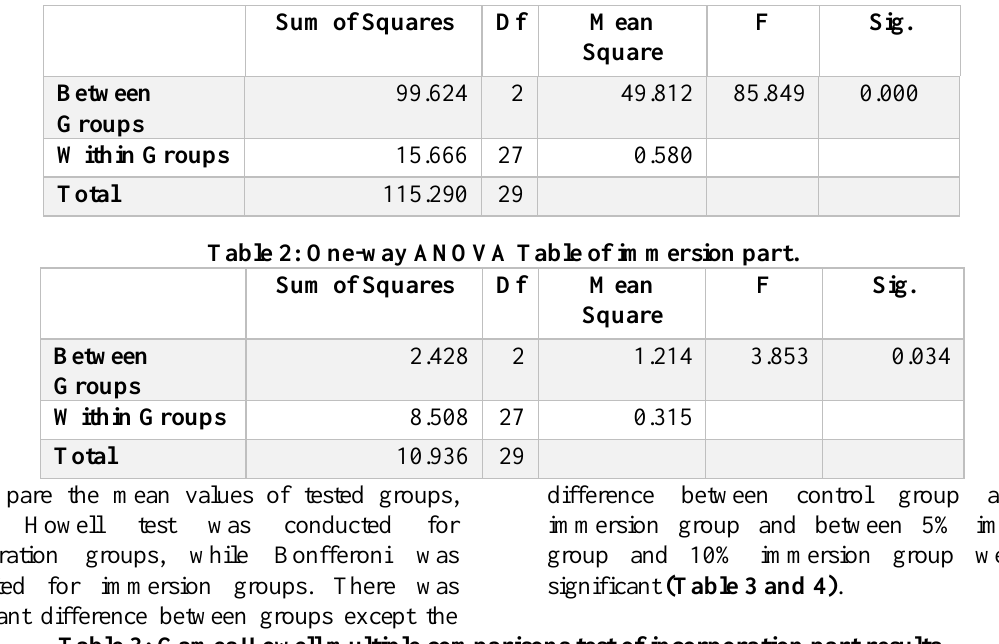
Table 1: One-way ANOVA Table of incorporation part.